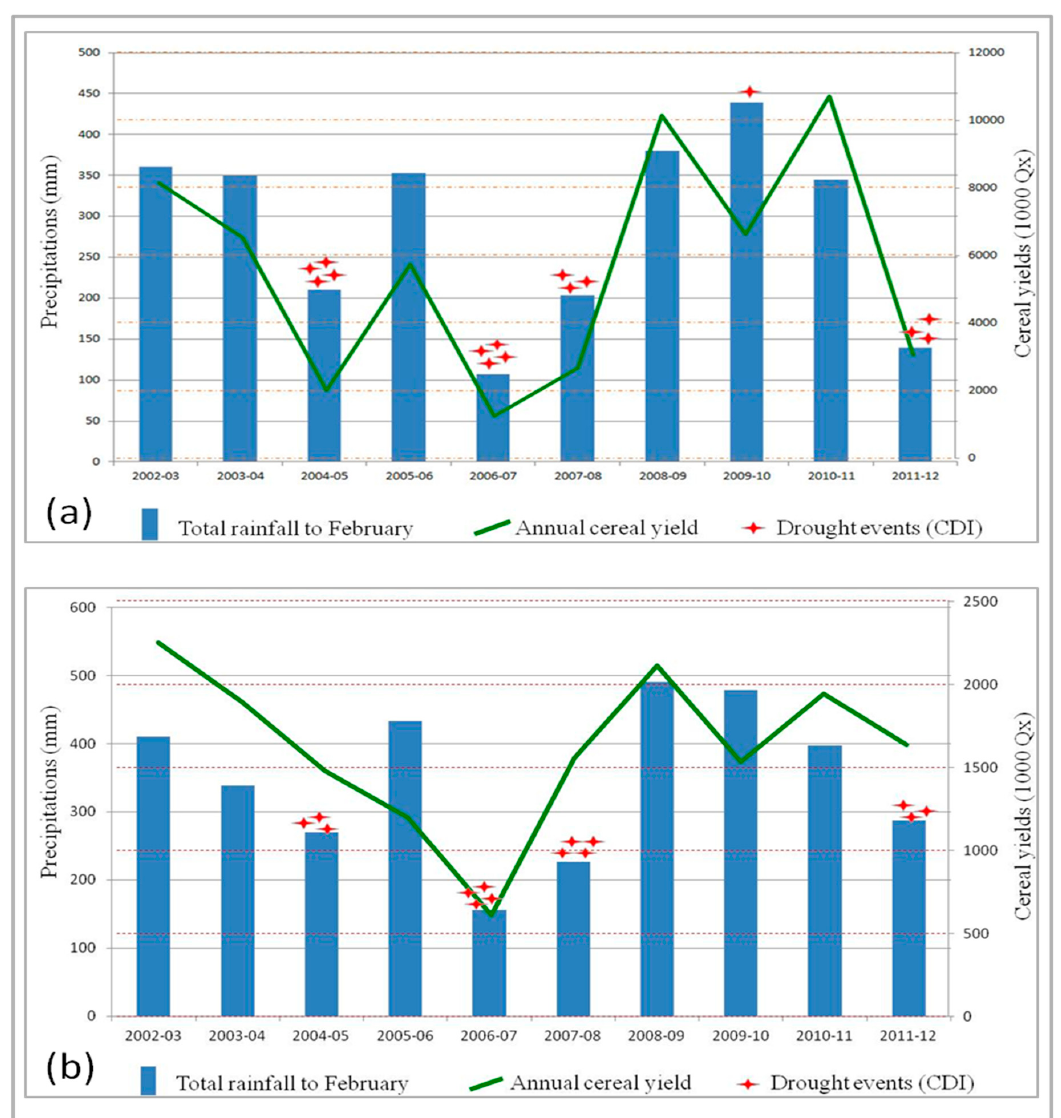
Figure 10. Comparison between annual cumulated rainfall through the end of February since